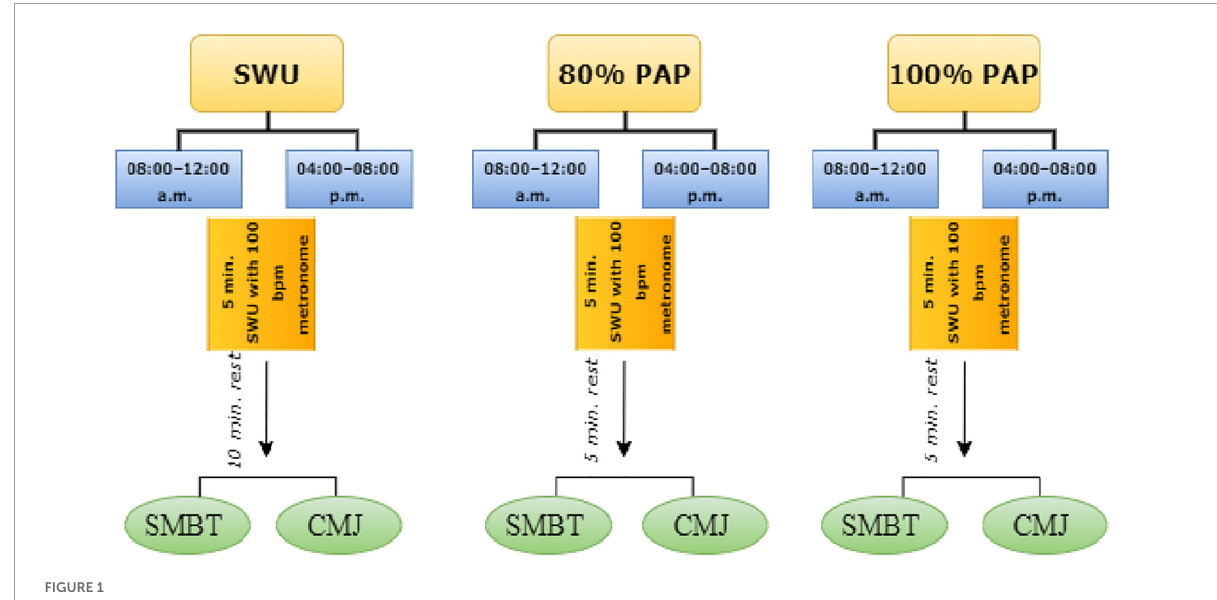
FIGURE1 The flow chart for experimental design of research.